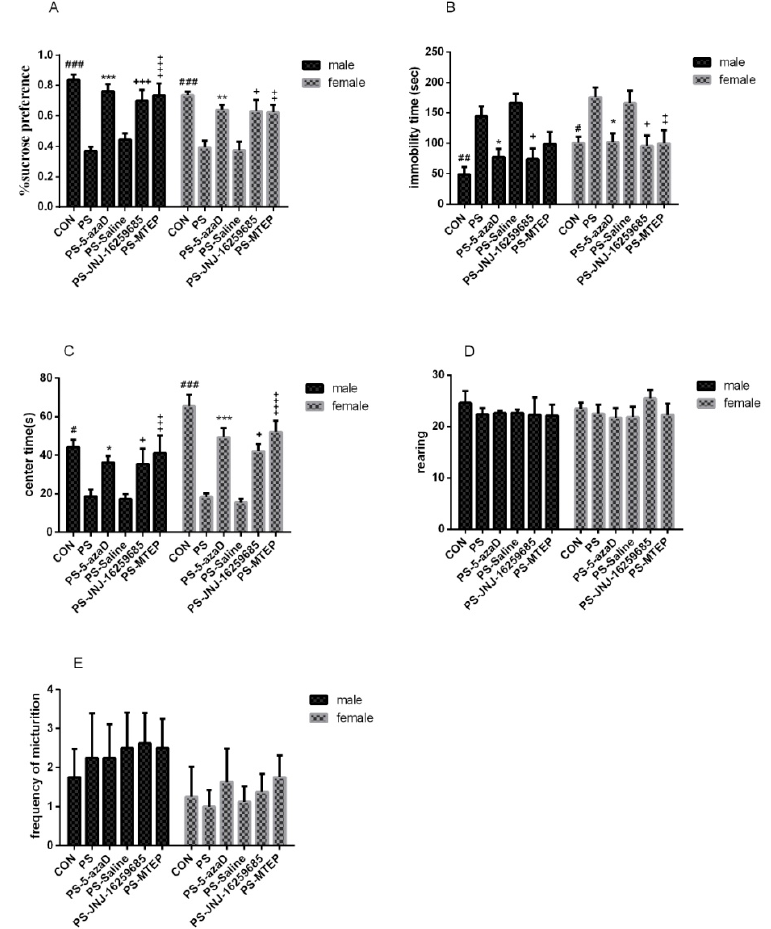
Figure 2. The depression-like behavior test of OR. ( A ) Sucrose preference in PS induced OR; ( B ) Immobility time in PS induced OR; ( C – E ) Center time, rearing, and frequency of micturition shown in six groups ( n = 8 each group). Data is expressed as mean ± SEM. ### p < 0.001, ## p < 0.01, # p < 0.05 compare with CON and *** p < 0.001, ** p < 0.01, * p < 0.05 compare with PS. +++ p < 0.001, + p < 0.05 compare with PS. ++++ p < 0.001, ++ p < 0. 05 compare with PS.